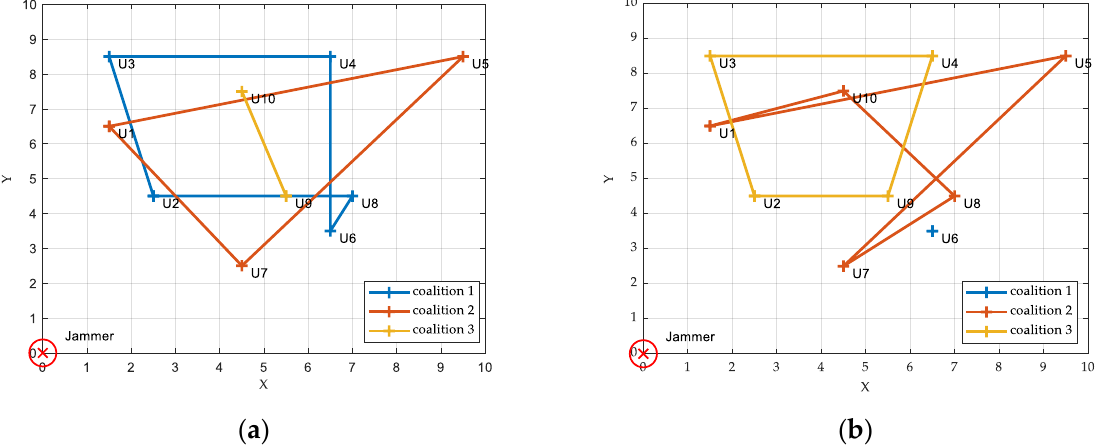
Figure 3. Schematic diagram of the change in coalition before and after using the MDACF algorithm: ( a ) before using MDACF algorithm; ( b ) after using MDACF algorithm.